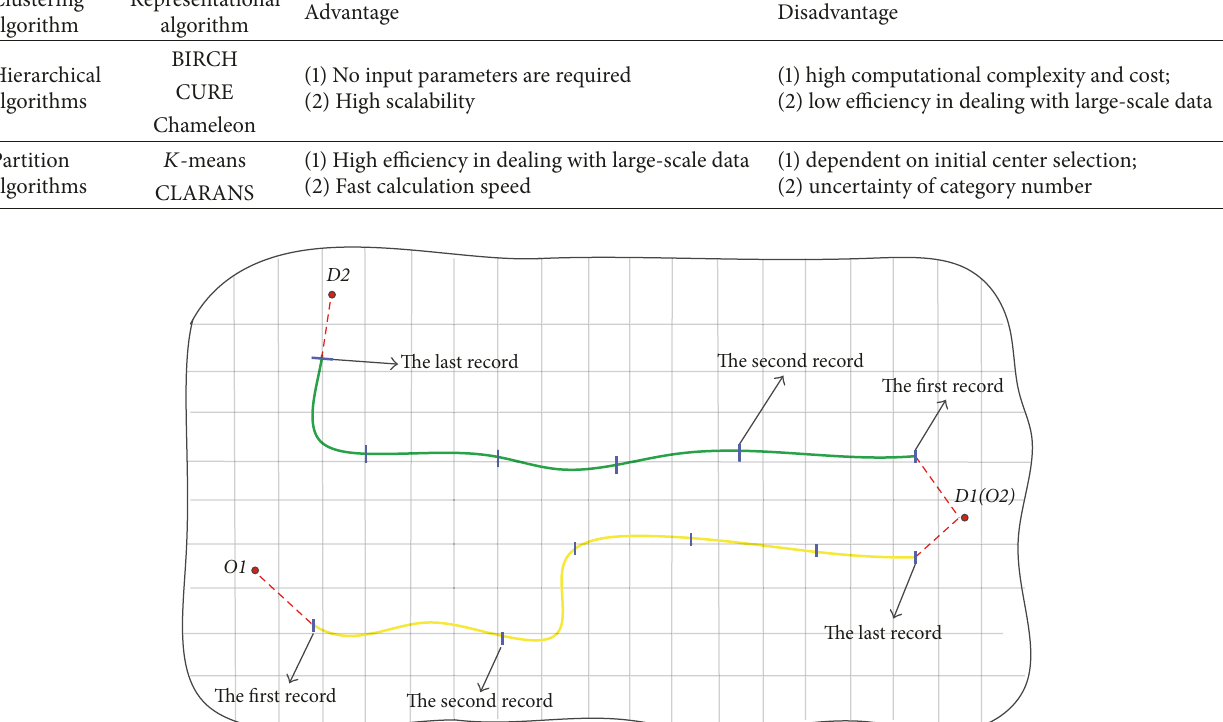
Figure 3: The relationship between the travel trajectory and the detection